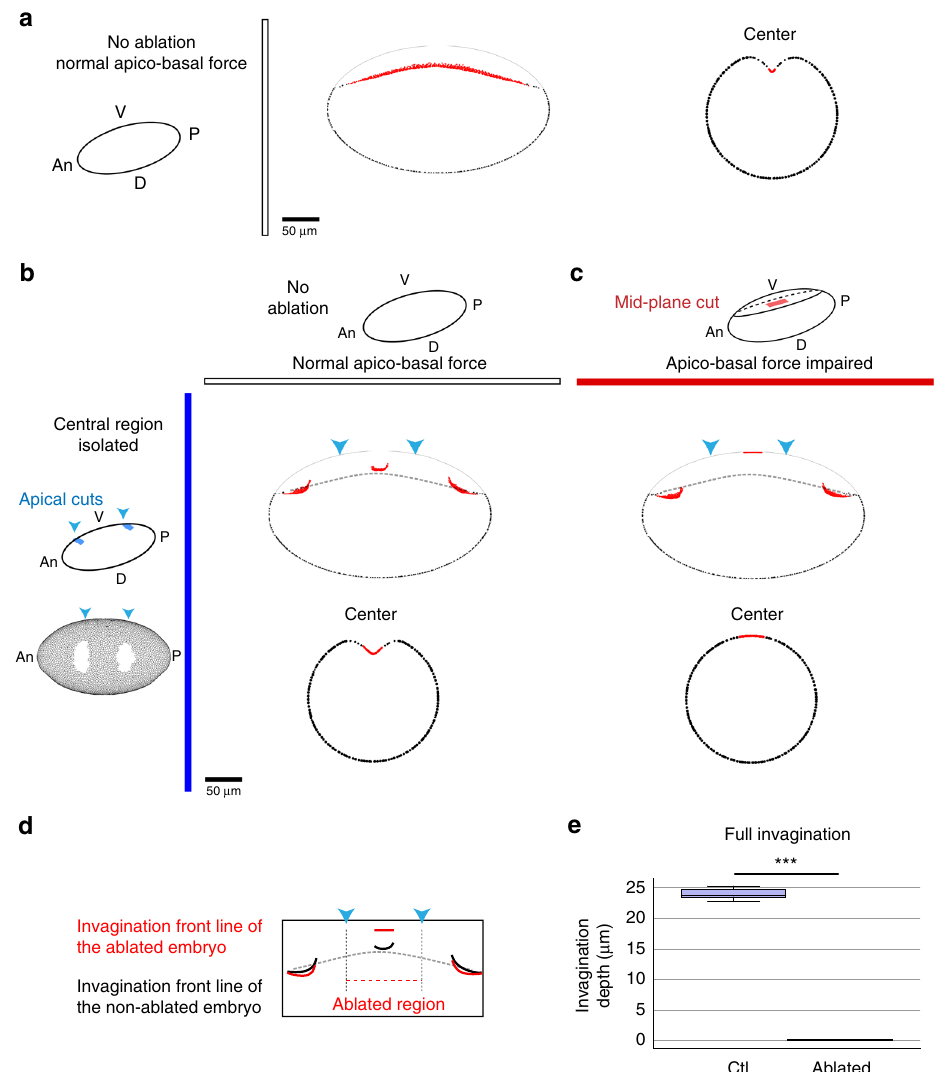
Fig. 9 Simulating laser ablations in a 3D biophysical model. Schemes recapitulate the different simulated ablations. The apical ablated region is indicated by blue arrowheads. It can be seen on the ventral view of the simulated embryo in b. The mid-plane ablation in ( c ) is represented by a red rectangle in the scheme. Longitudinal and transversal views correspond to time step 50, at this time the invagination is considered as complete; the gray lines represent the initial shape of the embryo. Ectodermal cell edges are in black and mesodermal cells in red. An: anterior, P: posterior, V: ventral, D: dorsal. a Longitudinal (left) and transversal (right) sections of the simulated embryo in the control condition. Scale bar: 25 µ m. b , c Longitudinal (top) and transversal (down) sections of the simulated embryos. The dashed gray lines in the transversal sections represent the position of the full invagination pro fi le for the control condition. The invagination is mostly unperturbed in the control condition ( b , n = 20), whereas it is totally prevented when apico-basal forces are impaired ( c , central region, n = 20). Scale bar: 25 µ m. d Invagination front lines of the simulated embryos shown in ( b ) and ( c ) highlighting the invagination defect in the absence of apico-basal traction compared to the control. e Invagination depth of the central region with (ctl) or without (ablated) apico-basal traction, measured respectively when the invagination is maximum. Statistical signi fi cance was assessed by the Mann − Whitney test (ctl: n = 20 and ablated: n = 20 at the end of the invagination: p = 3.4 × 10 − 8 — signi fi cant***). See also Supplementary Fig.